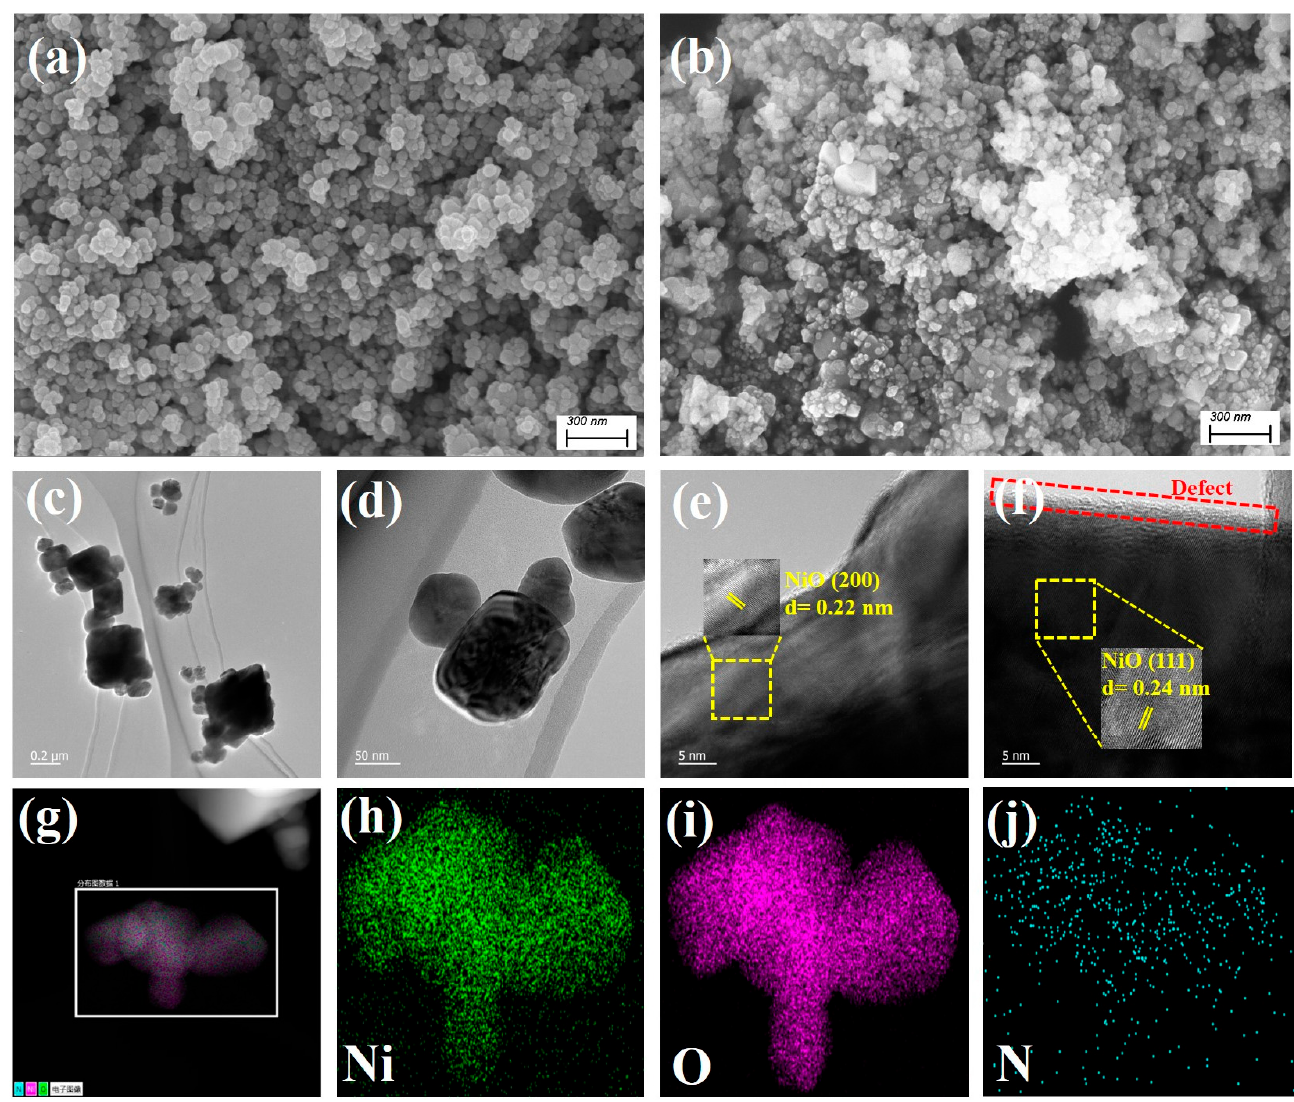
Figure 2. ( a ) SEM images of NiO and ( b ) N-NiO-2; TEM ( c , d ), HR-TEM ( e , f ), and element-mapping spectra of N-NiO-2 ( g – j ).